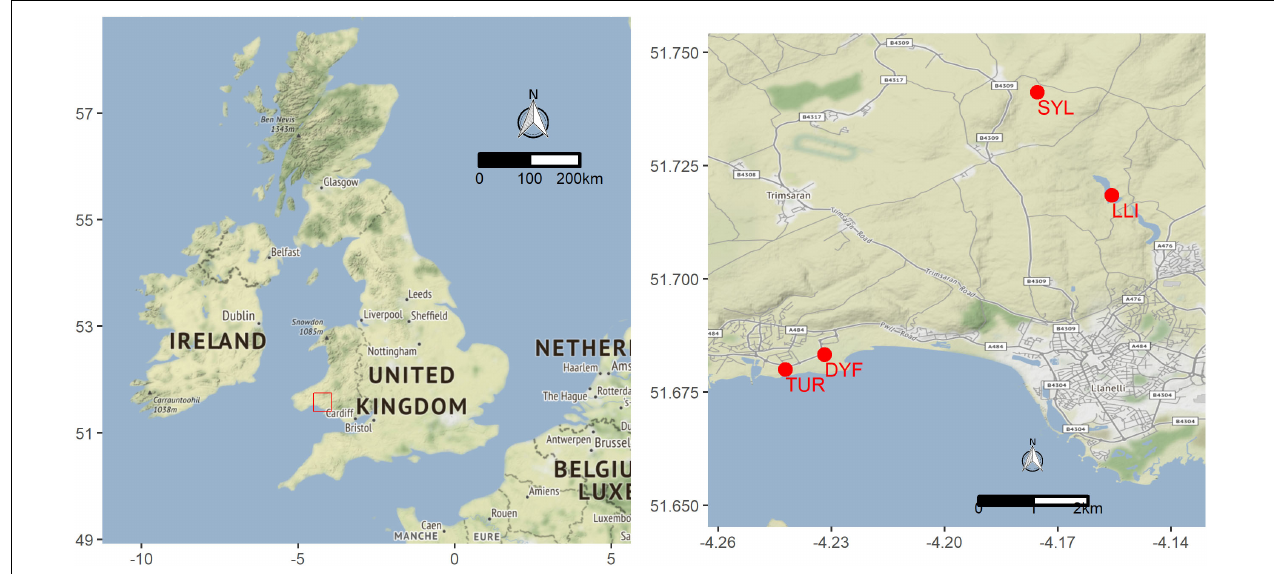
FIGURE 1 | Location of study sites sampled for topmouth gudgeon in Wales (UK): Upper Lliedi Reservoir – LLI, Sylen pond – SYL, Turbine pond – TUR, and Dyfatty pond – DYF. TABLE 1 | Characteristics of the four study sites examined for trophic position of topmouth gudgeon ( Pseudorasbora parva ) in South Wales.